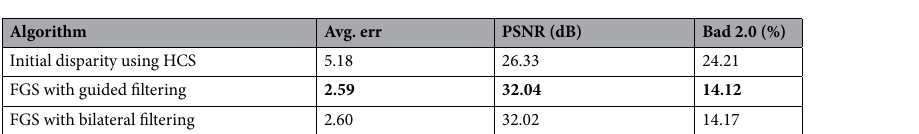
Table 2. Performance of the edge-preserving filters used for identifying variables nodes neighboring each dependency factor node in the FGS factor graph. Significant values are in bold.